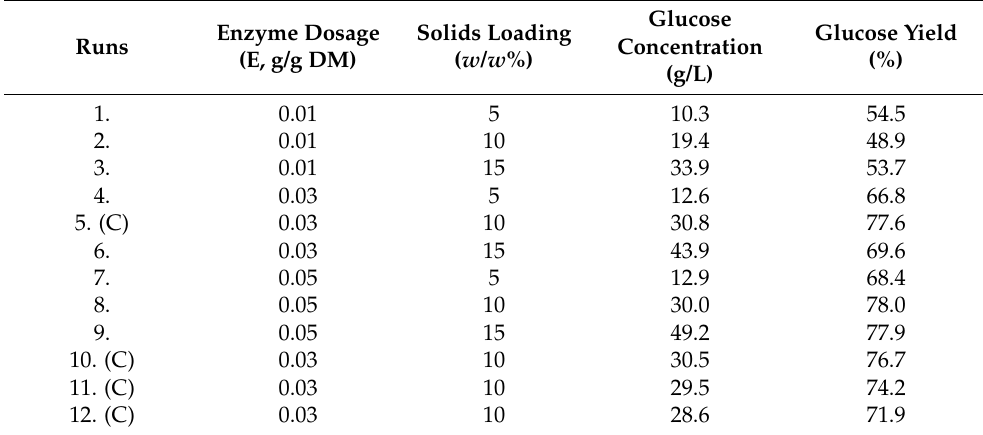
Table 4. The experimental set and results of the enzymatic hydrolysis of BSG residue. Enzyme Dosage Runs (E, g/g